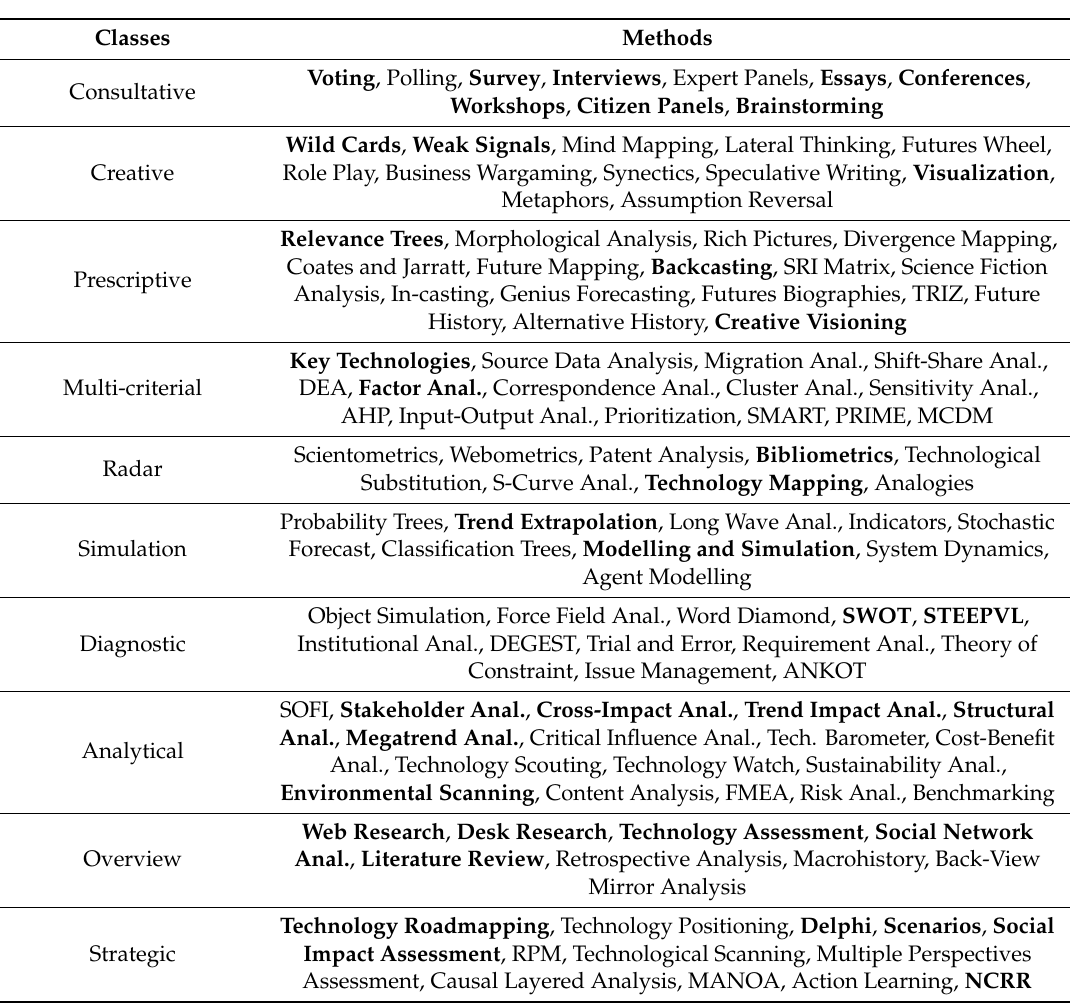
Table 1. Classification of foresight research methods with indications towards methods useful in foresight smart city based on